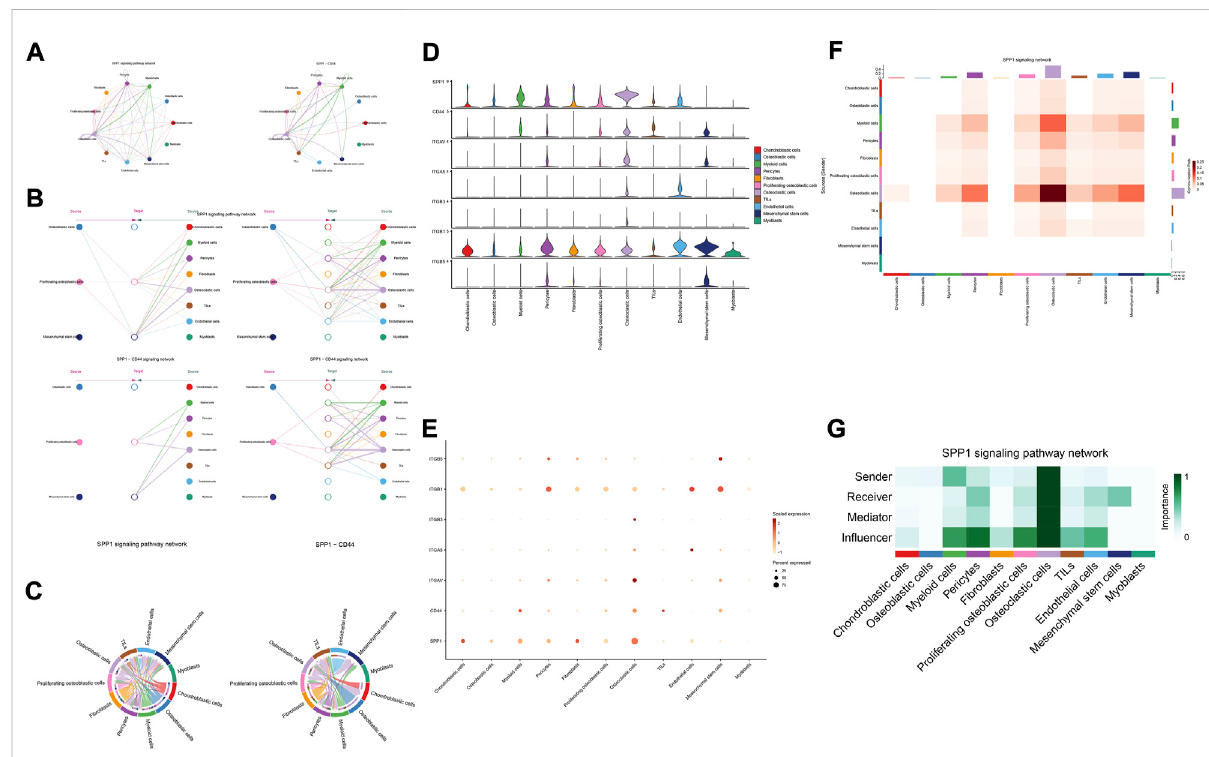
FIGURE 7 SPP1 signaling pathway. (A – C) : ligand-receptor interactions of cells. (D,E) : the ligand-receptors expressed by each major cell type. (F,G) : the network of SPP1 signaling